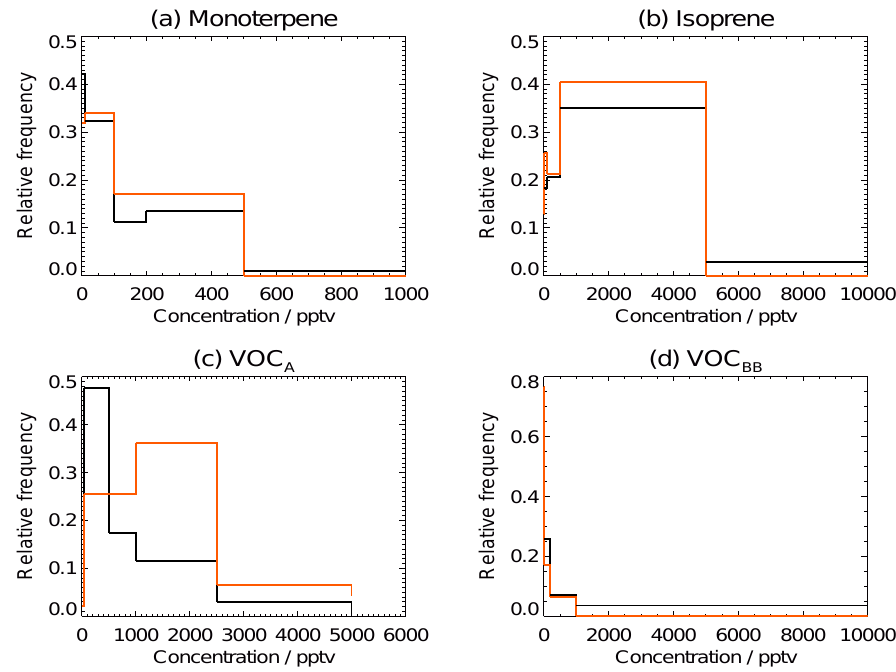
Fig. 6. Probability distribution of (a) monoterpenes, (b) isoprene, (c) anthropogenic VOC (VOC A ) and (d) biomass burning VOC (VOC BB ) as a function of concentration. The black line shows simulated probability distribution for all global land surface (excluding Antarctica). The orange line shows simulated distribution at the locations and times of the AMS